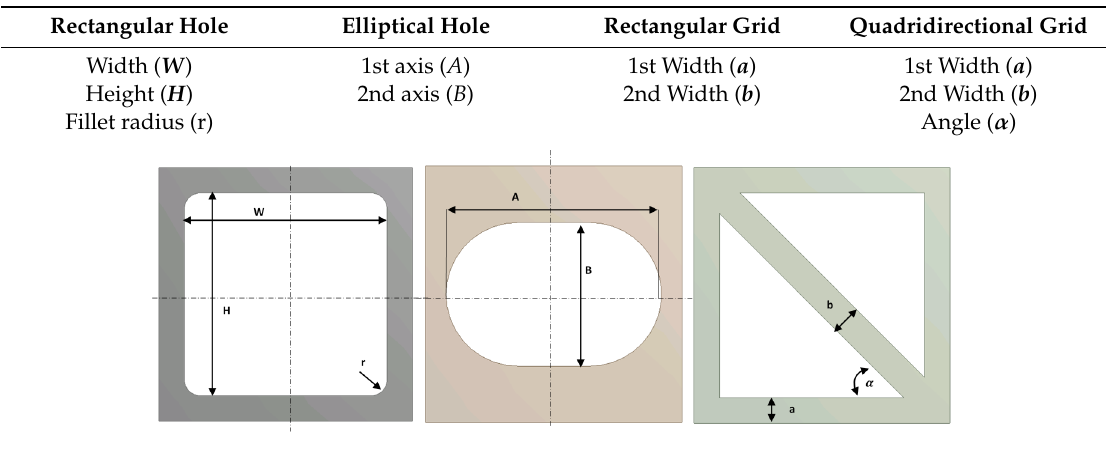
Table 4. Geometrical parameters for optimization.